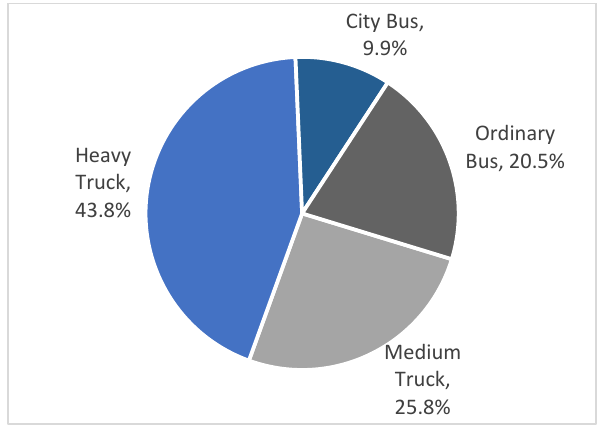
Figure 8. The share of Korea MHDV sector CO 2 emissions by source.